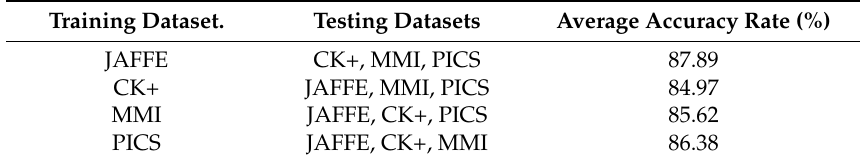
Table 2. Average accuracy rate of the proposed method trained on one dataset and tested on the others. Training Dataset.